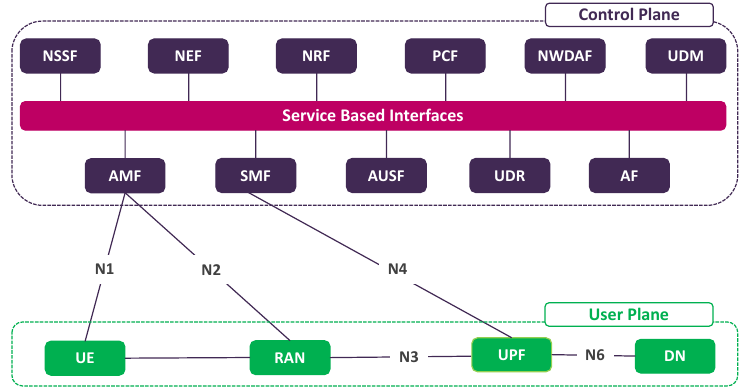
Figure 1. 5G Service Based Architecture.